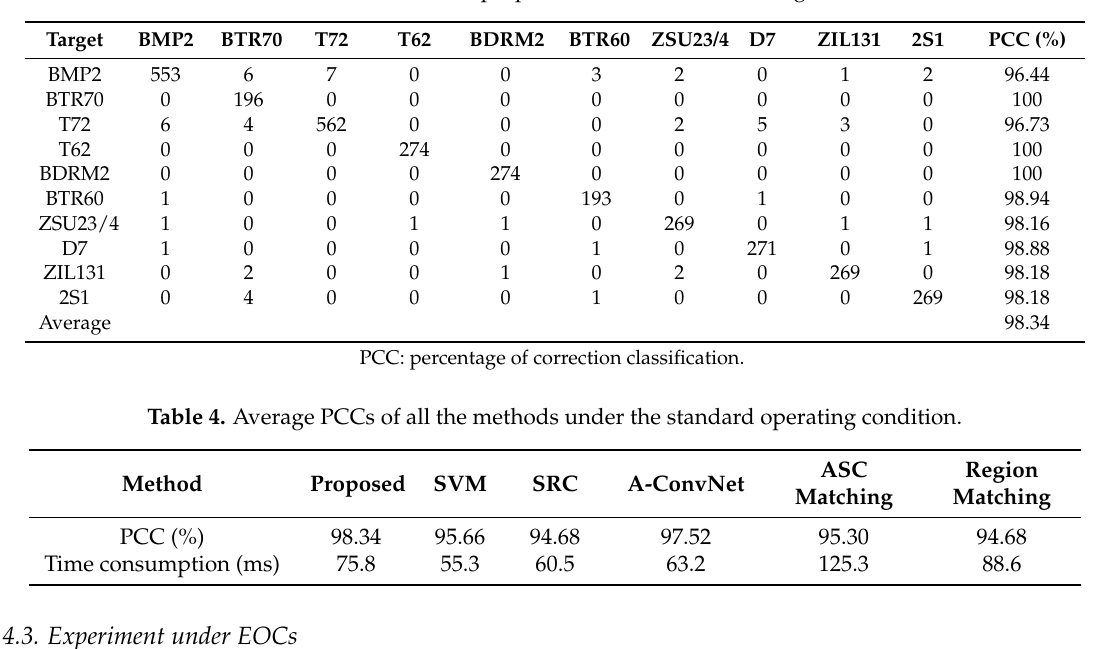
Table 3. Confusion matrix of the proposed method on the ten targets under SOC.